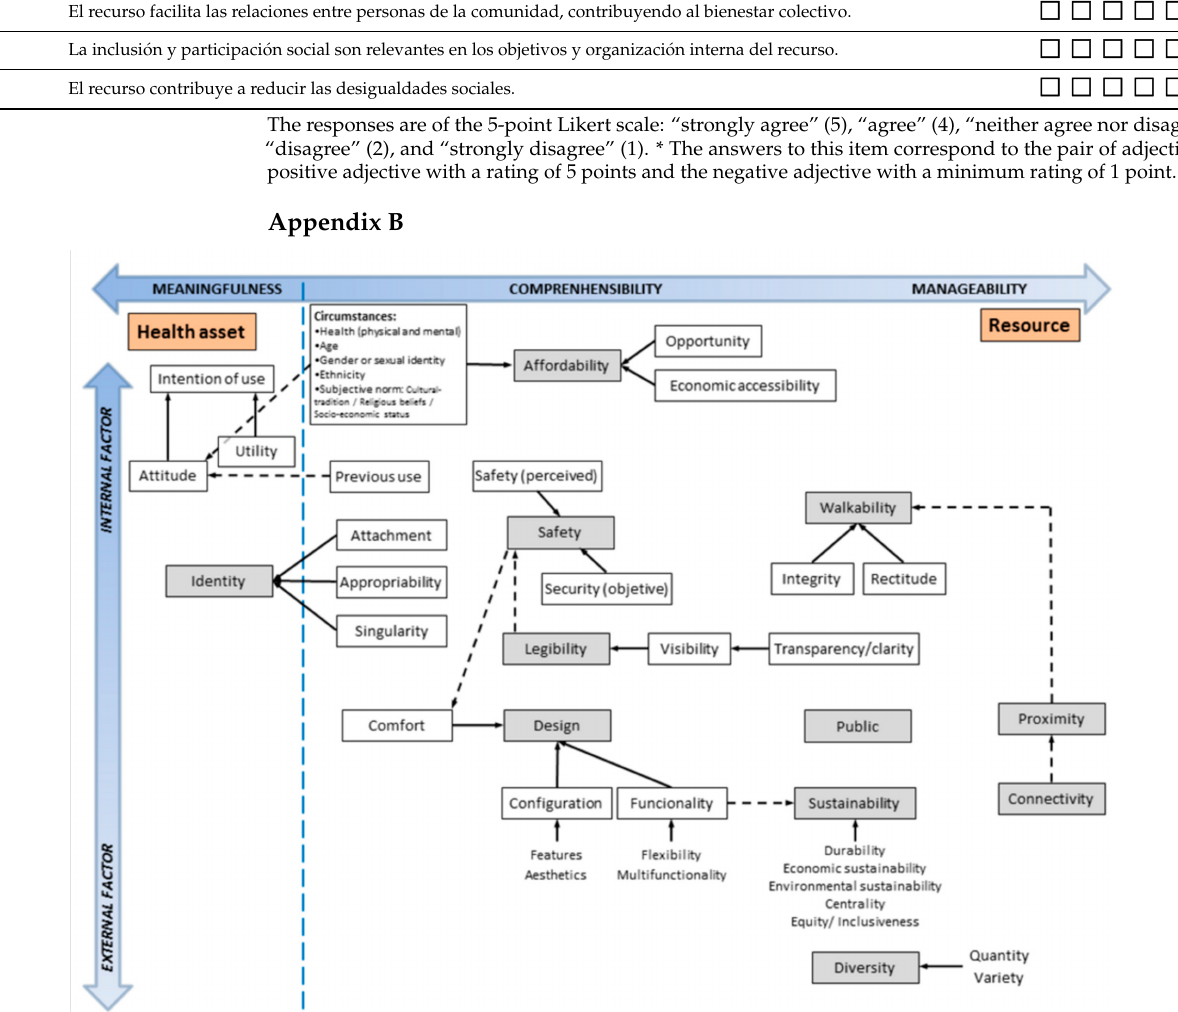
Table A1. Community assets for health assessment scale.